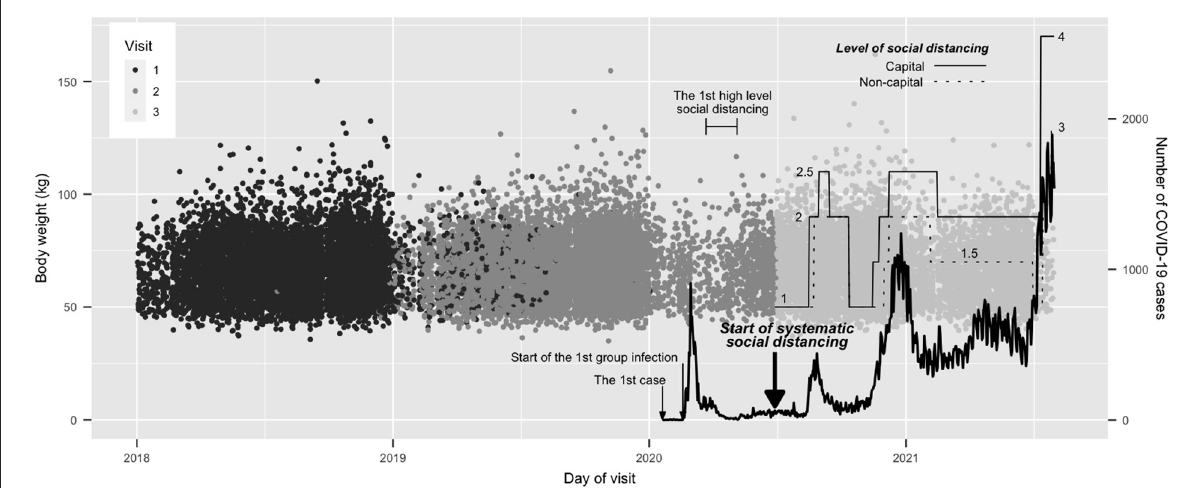
FIGURE1 Body weight on each visit day, along with the daily case numbers of COVID-19 and the level of social distancing. All final visits occurred after the start of the systematic social distancing, and all the first visits were before that. The levels of social distancing in capital and non-capital areas are shown, with the final four-level system. The solid line denotes a capital area and the dotted line denotes a non-capital area. The levels of social distancing in capital areas were always the same or higher than those in non-capital